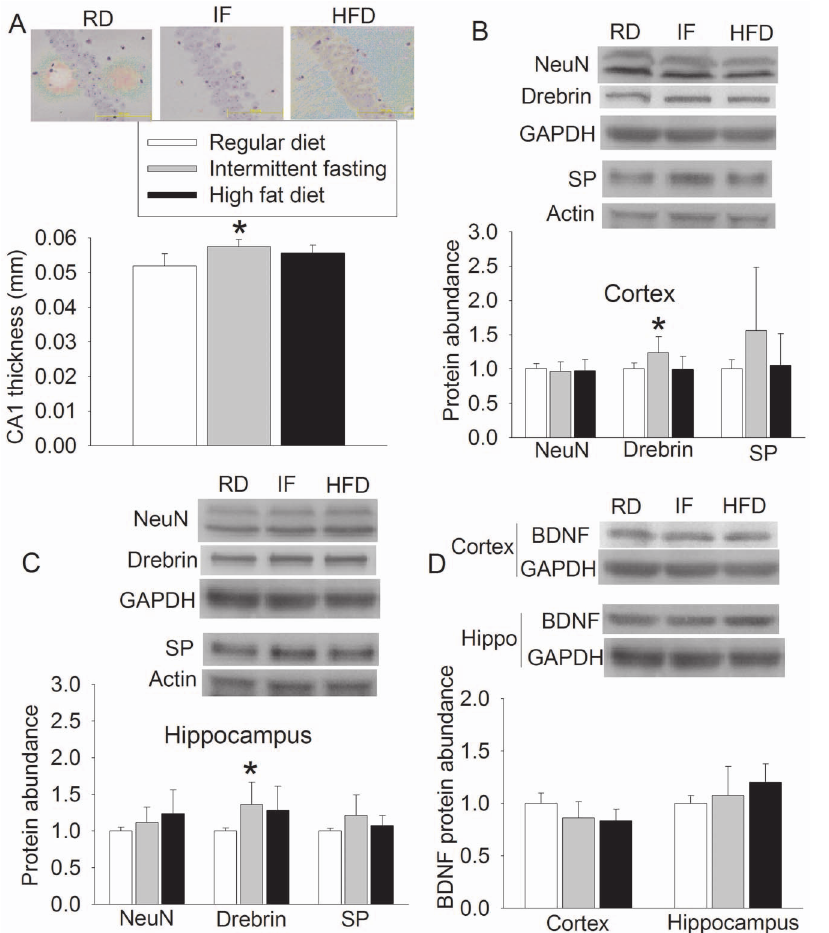
Figure 3. The effects of various feeding protocols on CA1 pyramidal cell layer thickness, neuron-specific proteins and brain derived neurotrophic factor (BDNF) in the brain. Seven-week old male mice had free access to regular chow or high fat diet or were allowed to have free access to regular chow every other day (intermittent fasting) for 11 months. Their brains were then harvested to measure CA1 pyramidal cell layer thickness (panel A) and expression of NeuN, drebrin and synaptophysin in the cerebral cortex (panel B) and hippocampus (panel C) as well as the BDNF levels in the cerebral cortex and hippocampus (panel D). The protein abundance results in each mouse were normalized by the mean value of the corresponding protein in the regular diet-fed mice. Results are means 6 S.E.M (n=7 – 12). * P , 0.05 compared with mice on regular diet ad libitum. GAPDH: glyceraldehydes 3-phosphate dehydrogenase; Hippo: hippocampus; SP: synaptophysin; RD: regular diet; IF: intermittent fasting; HFD: high fat diet.